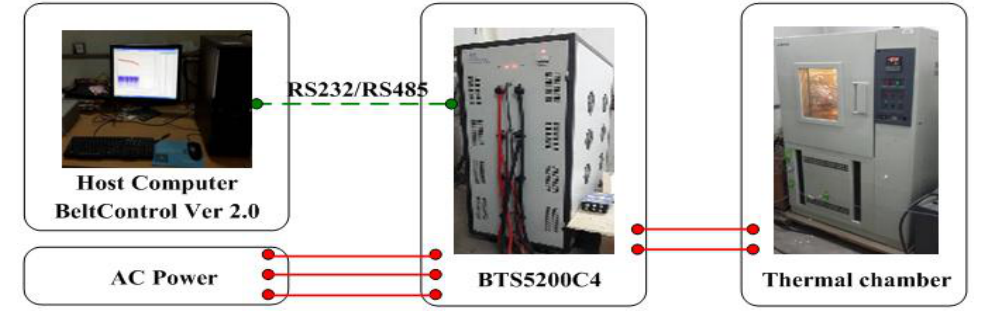
Figure 4. The battery test